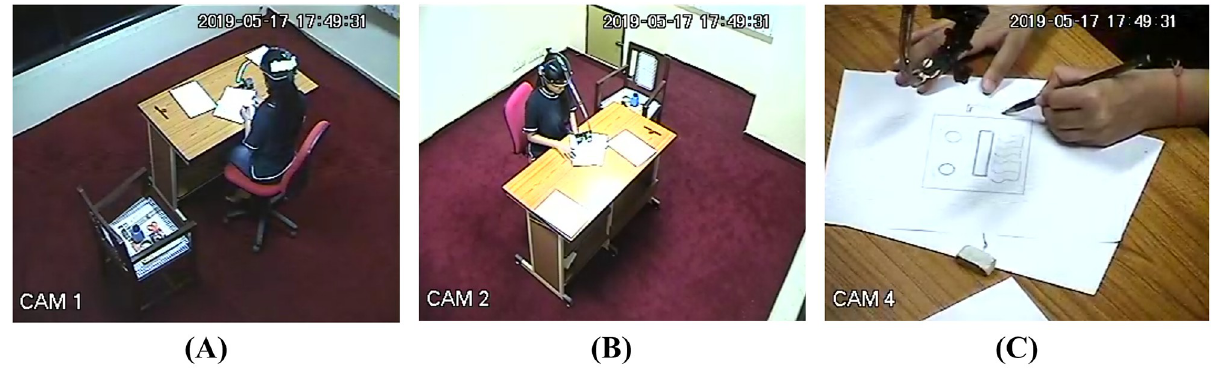
Fig 4. A three-camera view of the participant’s activity during the process. (A) A close-up view of the output is captured by the CAM4, (B) a medium close-up 3/4th view is captured by the CAM2, (C) and a zoom-out view of the overall activity is captured by the CAM1, in the psychology lab.